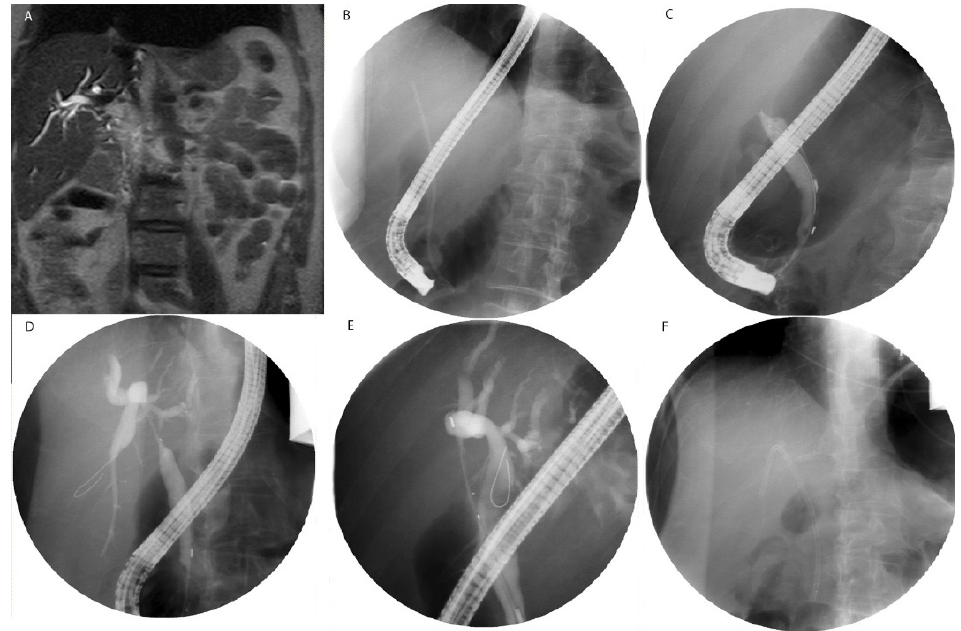
Figure 4. Representative image of PDT. ( A ) Sagital MR Abdomen T2 weighted image demonstrating a soft tissue perihilar mass and diffuse dilation of the intrahepatic biliary system in a 70-year-old male diagnosed with choliangiocarcinoma. ( B ) Initial flouroscopic image during ERCP demonstrating position of the scope and an intrahepatic biliary stent. ( C ) Following removal of the stent, contrast injection into the ampulla of Vater demonstrates common bile duct stricture. ( D ) After crossing the common bile duct stricture, injection of contrast media demonstrates the extent of focal common bile duct stricture and biliary dilation upstream. ( E ) Light diffuser is advanced over the stricture for application of PDT. ( F ) Following PDT session, the light diffuser is removed from the common bile duct and an endobiliary stent is placed.